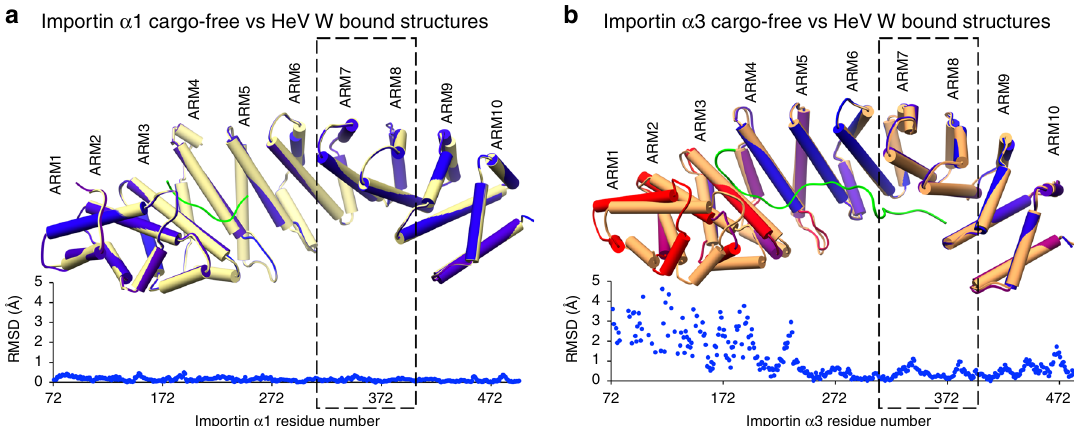
Fig. 6 Structures of cargo-free importin α 1 and α 3 con fi rm ARMs 7 and 8 positioning. a Importin α 1 cargo-free structure and structural superposition with importin α 1:HeV W complex (reference molecule, coloured yellow) and associated r.m.s.d plot. The positioning of the α -helices in ARM repeats 7 and 8 are static across all structures. The importin α 1 is coloured by r.m.s.d rendering where blue < 2.5 Å variance, and red for variances above 2.5 Å. b Importin α 3 cargo-free structure, together with the associated structural superposition with importin α 3:HeV W complex, and r.m.s.d plot. Importin α structures were aligned in UCSF Chimera using MatchEnsemble, and r.m.s.d. plots were generated using MatchAlign, and MatchAssess functions. Colouring as per a , but with importin α 3:HeV W in orange